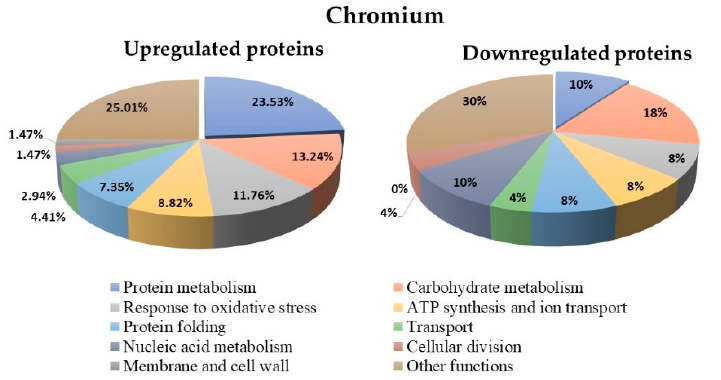
Figure 7. Biological function classification of the 118 up- and downregulated proteins under Cr 2+ ion treatment in Y. lipolytica AMJ6.